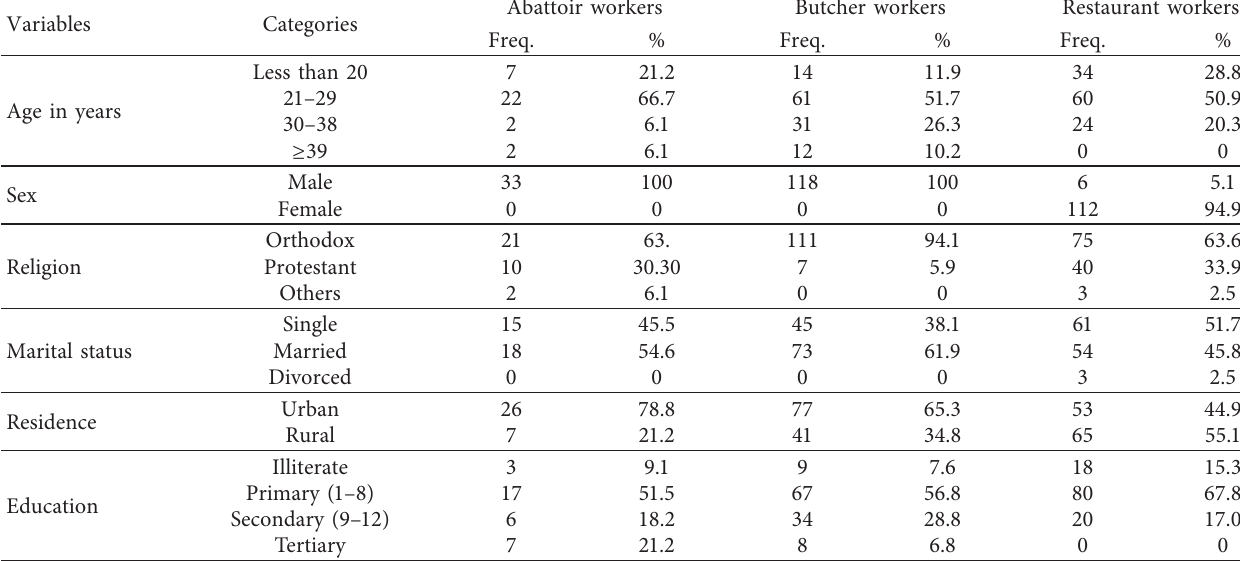
Table 5: Sociodemographic characteristics of abattoir, butcher, and restaurant workers in Ambo and Holeta towns. Variables